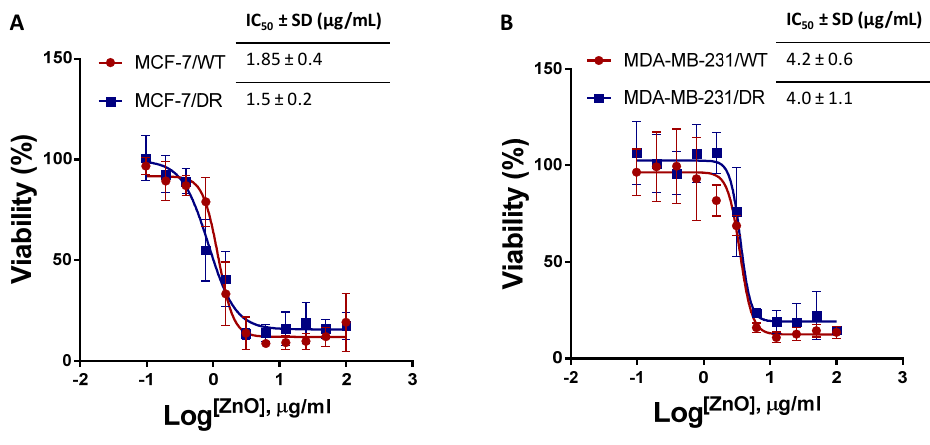
Figure 5. Dose–response curves. ( A ) Dose–response curve with IC50 of MCF-7/WT and MCF-7/DR cells after treatment with different concentrations of ZnO NPs for 72 h using the MTT assay. ( B ) Dose–response curve with IC50 of MDA-MB-231/WT and MDA-MB-231/DR cells after treatment with different concentrations of ZnO NPs for 72 h using the MTT assay ( n = 3). Apoptosis assay was performed to investigate the mechanism of cell death results